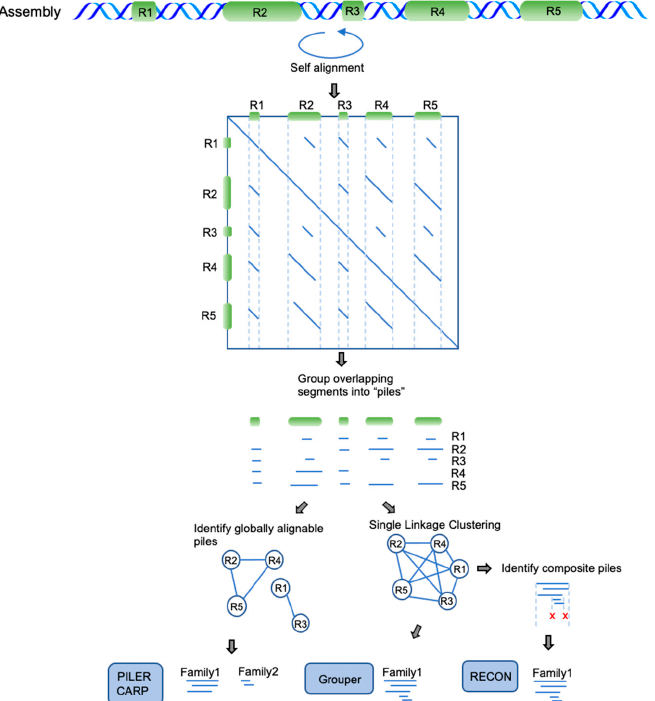
Figure 3. Self-comparison approaches. These methods attempt an all-vs.-all self-alignment using the whole assembly or a portion thereof. The self-alignments, viewed as a dot plot, will have many off- diagonal alignments representing dispersed similarities. These methods group the alignments into “piles”, defined by their distinct coverage across a region of the assembly. The primary difference between methods is in how they group piles into families. PILER and CARP require that elements are globally alignable, thereby identifying R1/R3 as a distinct family rather than fragments. Grouper and RECON apply single-linkage clustering, which, in this example, groups all fragments into a single family. RECON further attempts to identify composite families by looking for overrepre- sented internal edges—in this example, the internal edges were not deemed significant (red x’s).